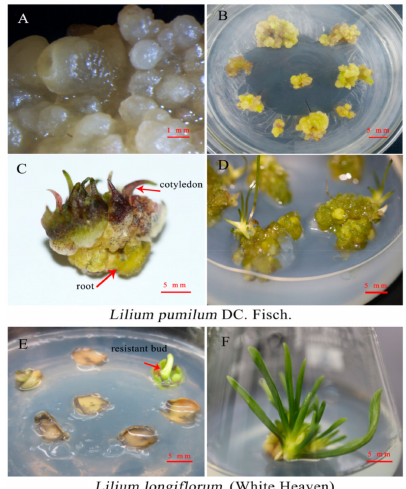
Figure 2. Plant tissues at di ff erent stages of Agrobacterium -mediated transformation of Lilium . A – D Formation of transformed plants of Lilium pumilum DC. Fisch. A New embryogenic cells of resistant callus. B Resistant callus germination. C Resistant buds formed during germination. D Transformed plants. E – F Formation of transformed plants of ‘White Heaven’. E Resistant bud. F Transformed plants of ‘White Heaven’.